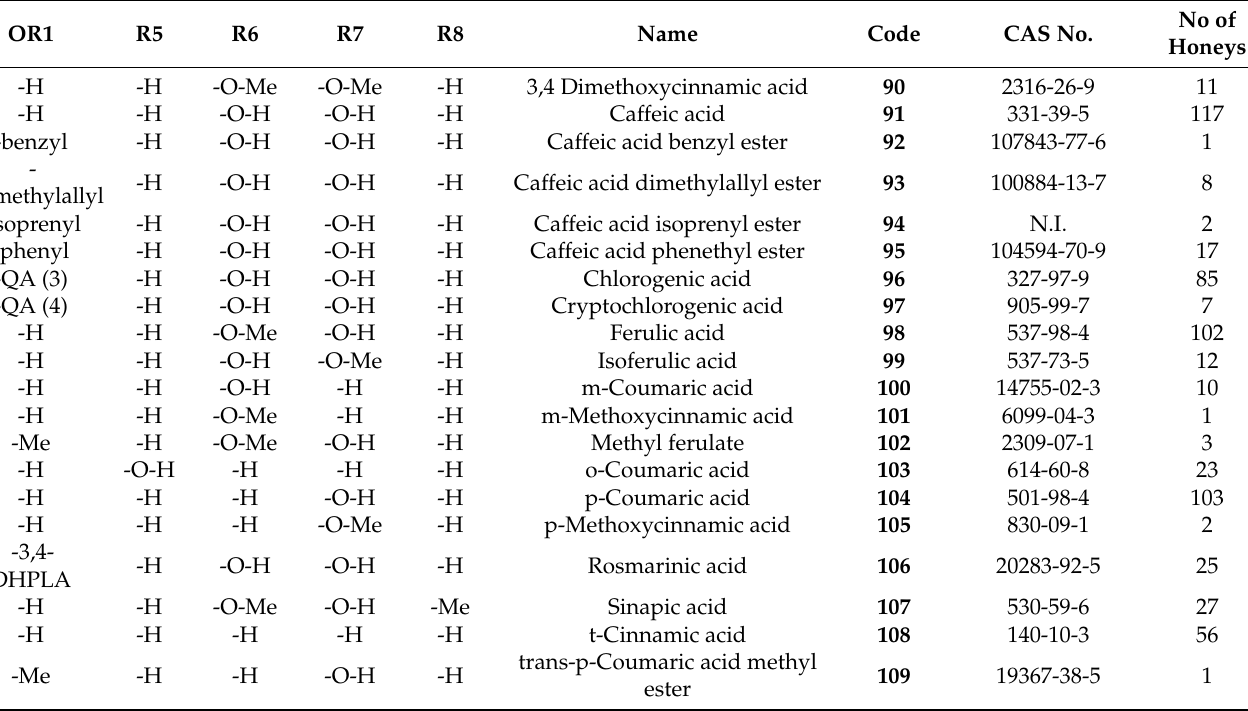
Table 9. Hydroxycinnamic acid and its derivatives reported in monofloral honeys (see Figure 14 for general structure).